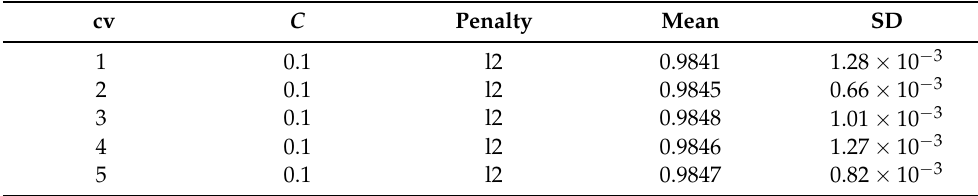
Figure 3. Logistic regression mean score by iteration. Table 5. Best logistic regression model by iteration.